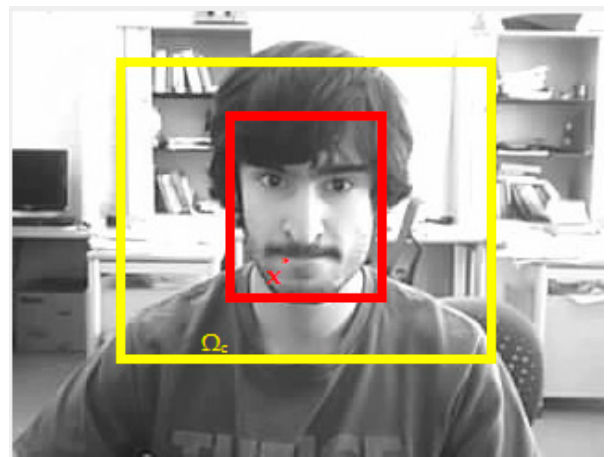
Figure 2. The spatial relation between object and its context. Picture in the figure is part of OTB-100 dataset [26].